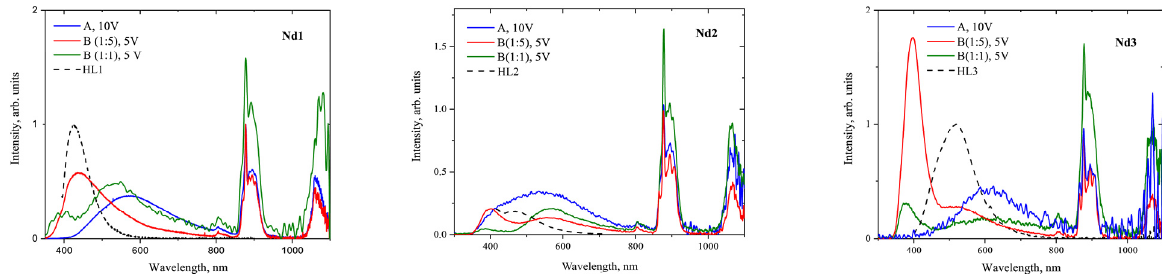
Figure 9. Comparison of the electroluminescence spectra for thermally evaporated A structures, and B structures with a spin-coated [complex:TCTA] layer with 1:1 and 1:5 ratios. The photoluminescence spectra of the neat main ligands are shown with dashed